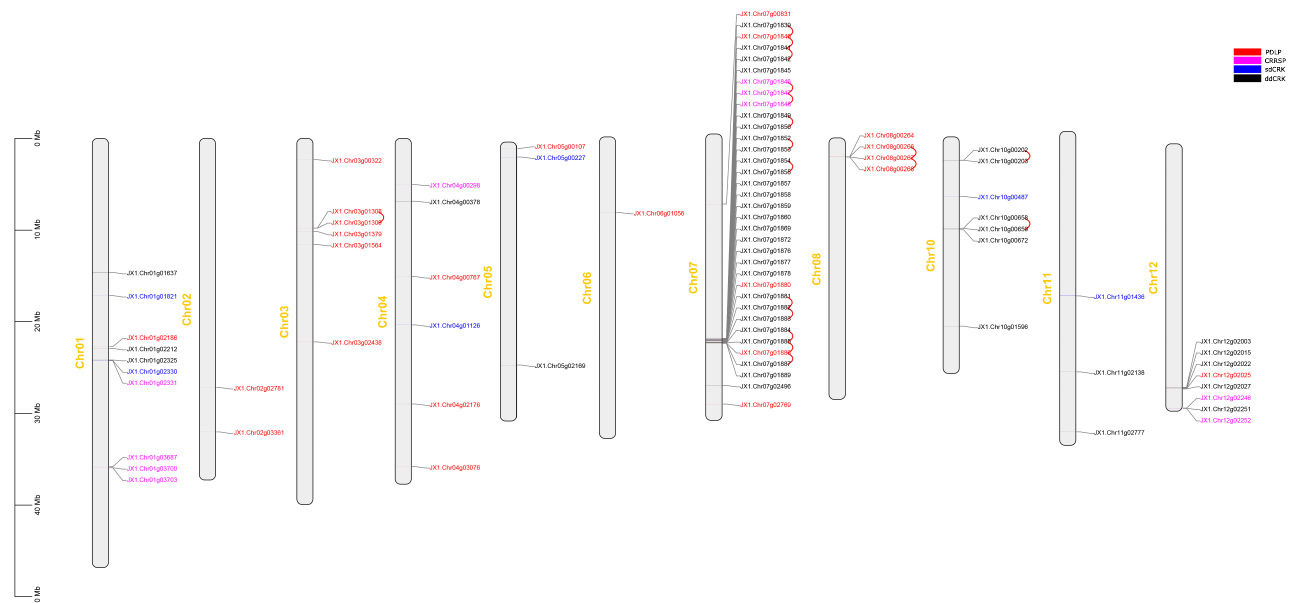
Figure 1. The distribution of DUF26 domain-containing genes on chromosomes. Different colors represent different types of DUF26 containing genes, in which red represents PDLPs, magenta represents CRRSPs, blue represents sdCRKs, black represents ddCRKs, and the red connecting line represents tandem repeat gene